Question: Express in one sentence what the figure is showing.
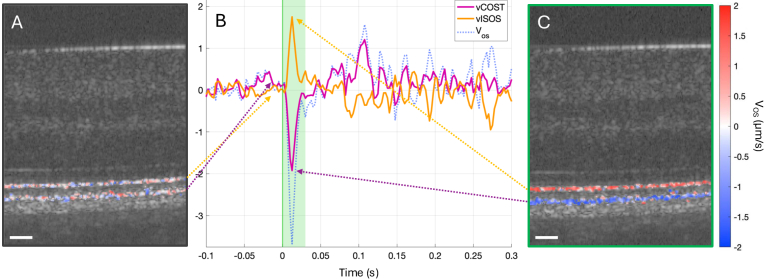
Answer: Pixel-wise spatial localization of the ORG signal. By calculating the velocity ORG curves for the ISOS and COST layers separately, we can identify which pixels in each layer contribute to the resulting averaged curve. A) Baseline ORG pseudo-colour image extracted immediately before the stimulus. B) Averaged velocity ORG curve averaged across the field of view, showing the V COST (magenta), V ISOS (yellow), and V OS (dashed blue) curves independently. C) ORG pseudo-colour image extracted at the time point of maximum contraction. Red-shifted pixels denote positive (downward) velocity, while blue-shifted pixels denote negative (upward) velocity.